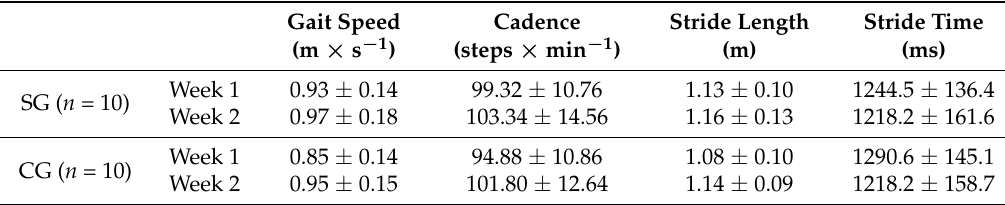
Table 4. Gait speed, stride length, cadence, and stride time of SG and CG for week 1 and week 2. Values are means ± standard